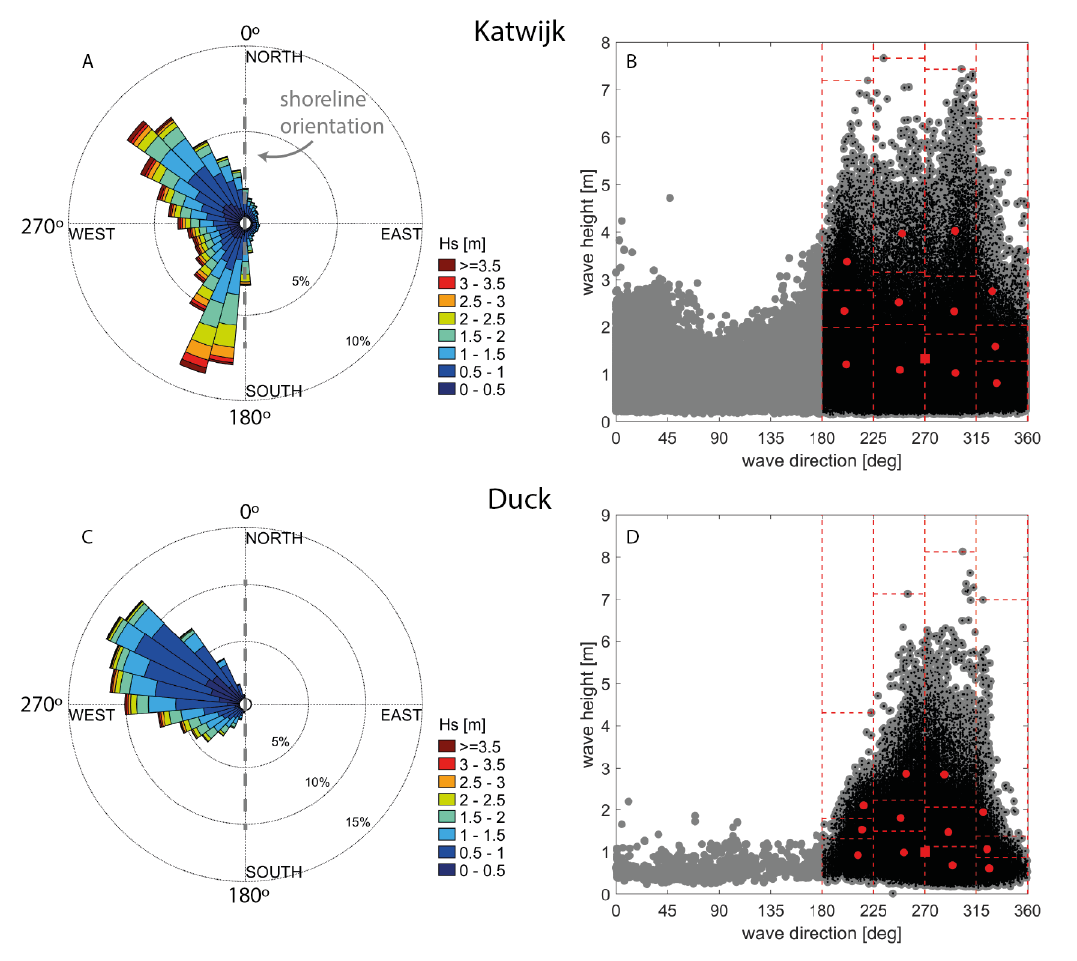
Figure 2. Measured and reduced wave climate at Katwijk and Duck. ( A , C ) Measured wave polar histogram for significant wave height ( H s ); ( B , D ) and the reduction to wave bins for modelling. Data for Katwijk ( A , B ) recorded at the IJmuiden ‘Munitiestortplaats’ between 1990 and 2016. Directions were rotated 30 ◦ for application in the model domain. ( C , D ) Data for Duck collected near the FRF Pier from 1997 to 2018 after 161 ◦ rotation. ( B , D ) Measured wave heights (gray) were filtered to selected onshore-directed cases (black). Red lines divide each wave bin into equal energy and red dots are reduced wave conditions that represent the quadrant. The red square represents the average condition in the shore-normal propagation direction. Reduced wave conditions are presented in Table